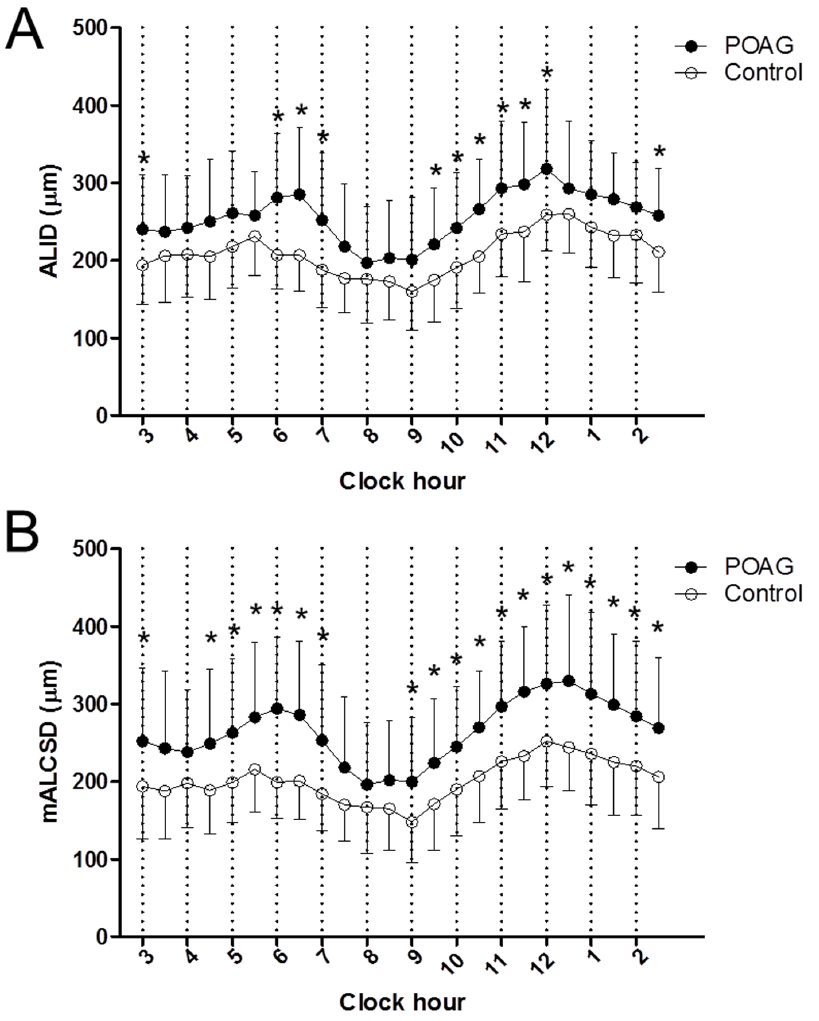
Fig. 5. Comparison of ALID (A) and mALCSD (B) between subjects with POAG and healthy controls in each meridian. Significant differences after Bonferroni correction ( p , 0.002) are indicated with